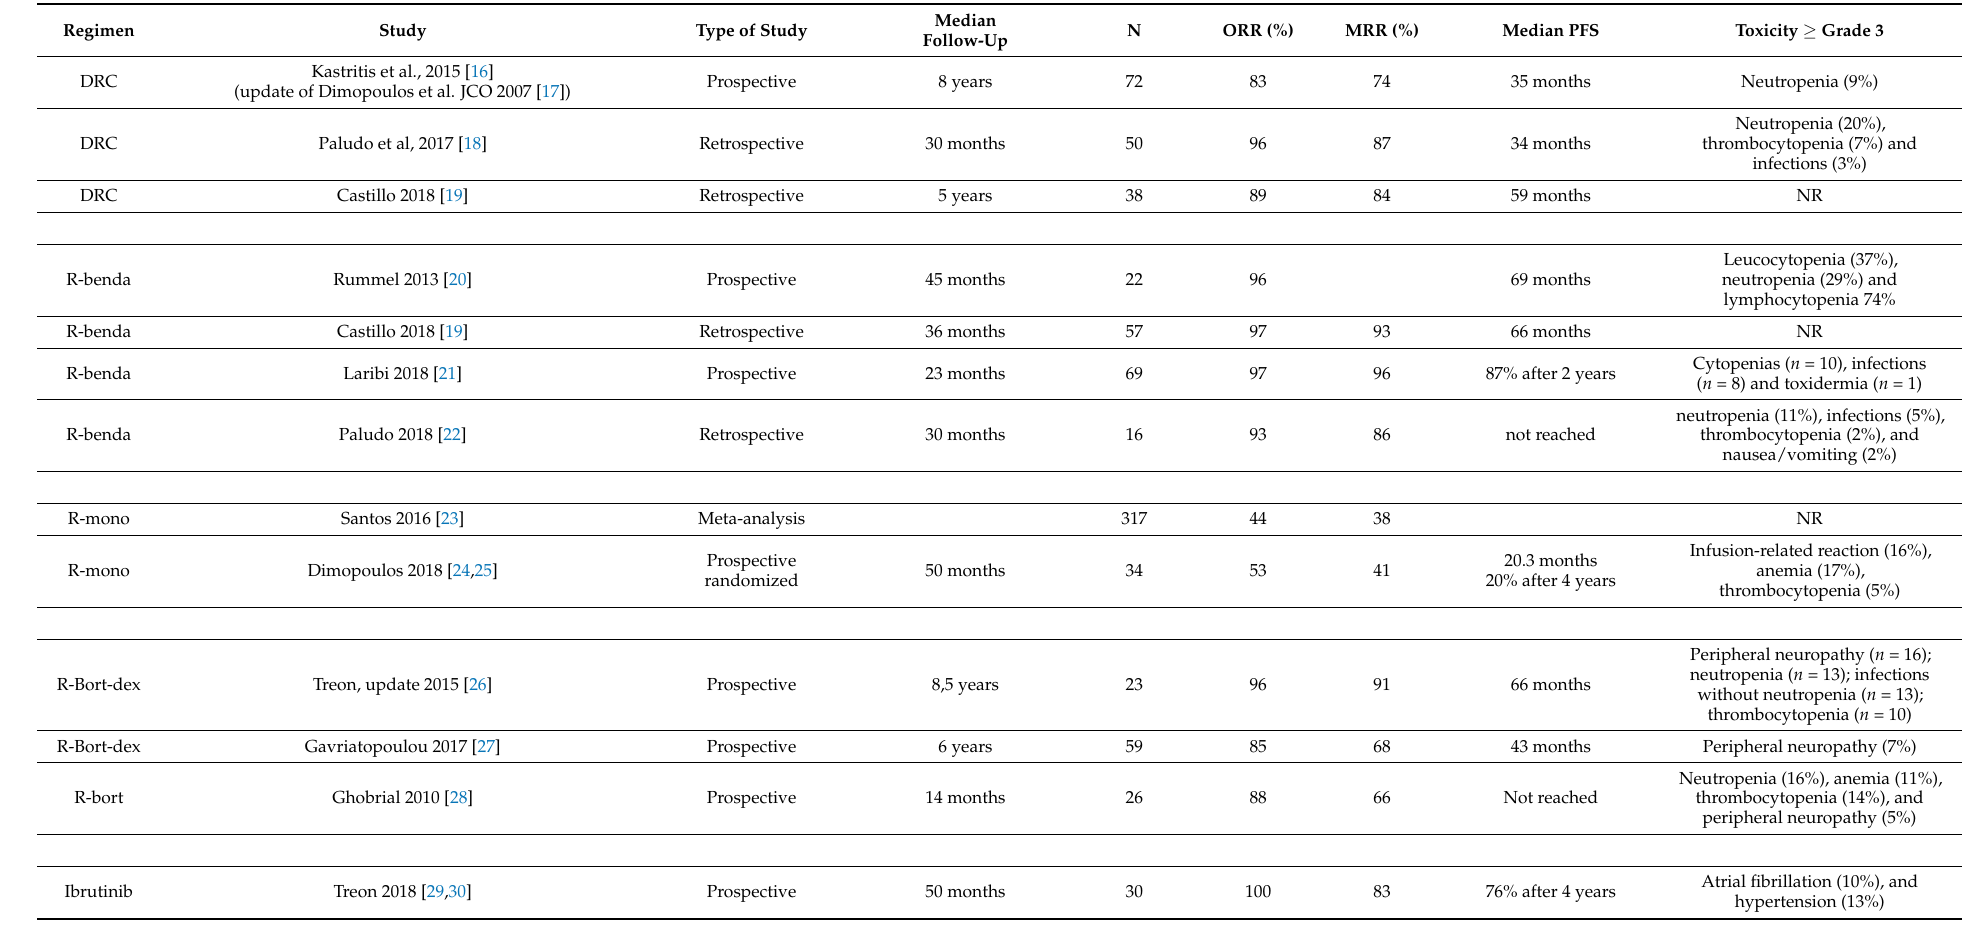
Table 2. Summary of the literature on various treatments in the